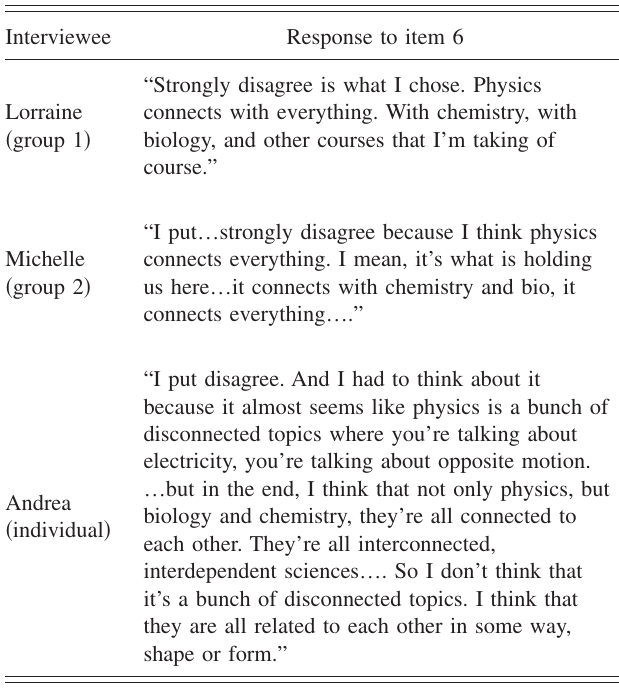
TABLE III. Interviewee responses from two different groups to the CLASS item 21 that differed from the intended